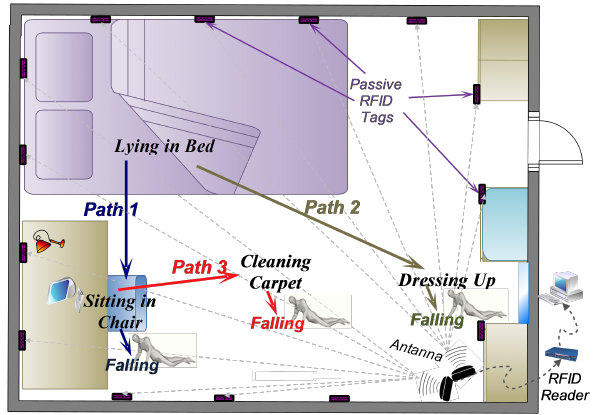
Figure 10: Types of normal activities